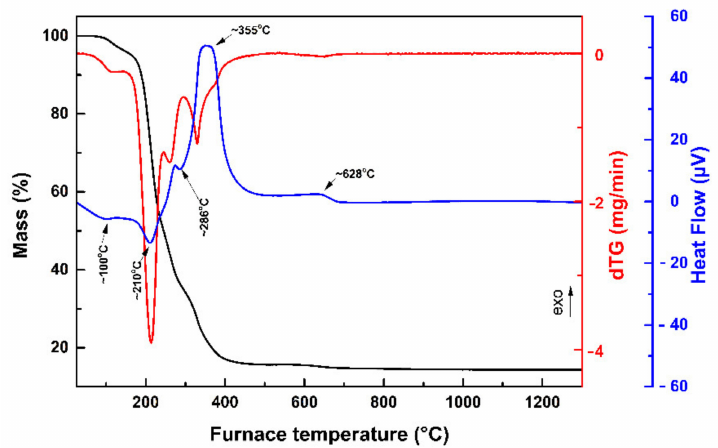
Figure 1. TG, dTG and Heat Flow curves of the gel at 10 ◦ C/min heating rate in dry